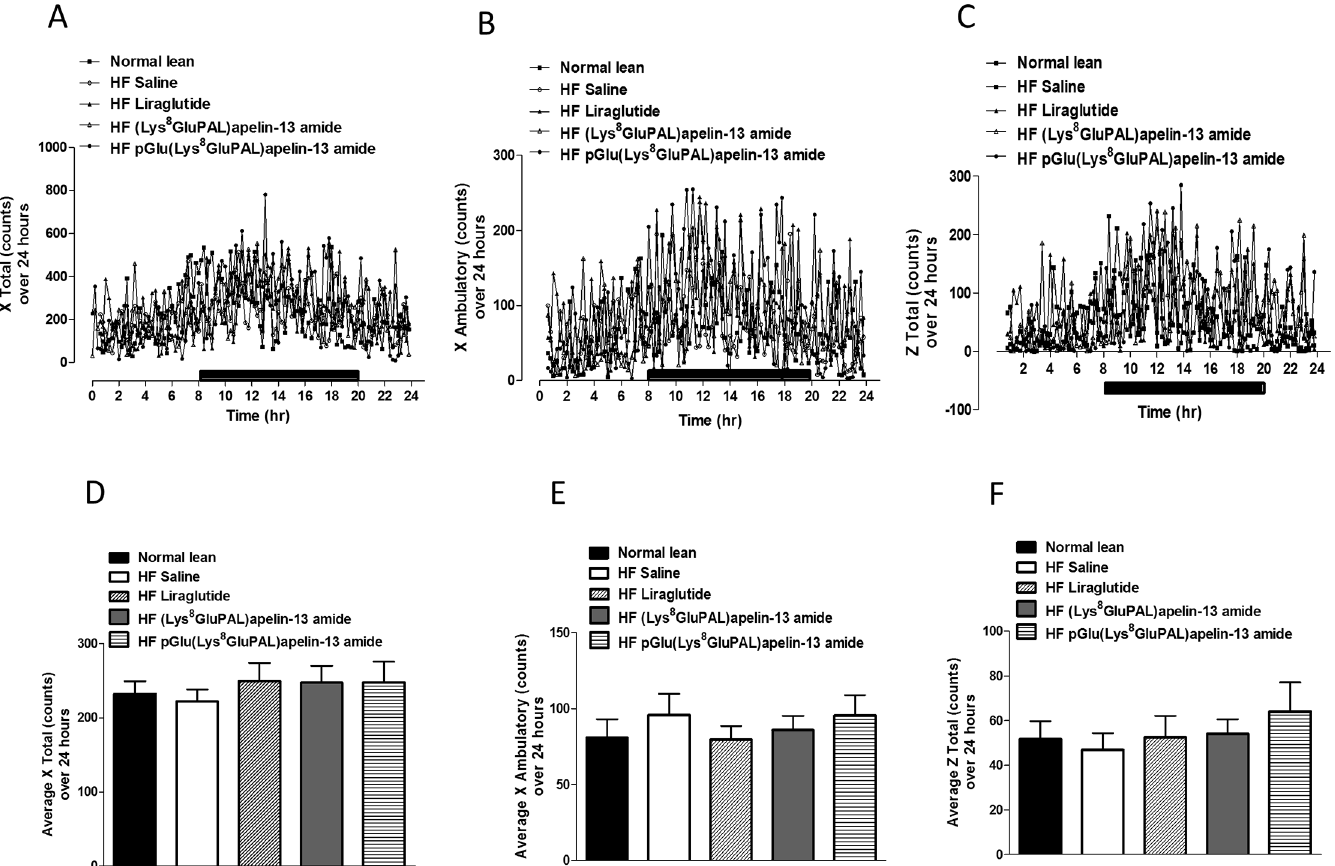
Fig 9. Effect of once daily i.p. administration of liraglutide, (Lys 8 GluPAL)apelin-13 amide or pGlu(Lys 8 GluPAL)apelin-13 amide (each at 25 nmol/kg bw) on locomotor activity. Following 35 days treatment, mice were placed in CLAMS metabolic chambers for 24 h (12 h dark period as shown by the black bar). Activity counts in X-axis (lateral) (A-D) and Z-axis (vertical) (E-F) were recorded every minute for the duration. Values represent the mean ± S.E.M. (n = 6).